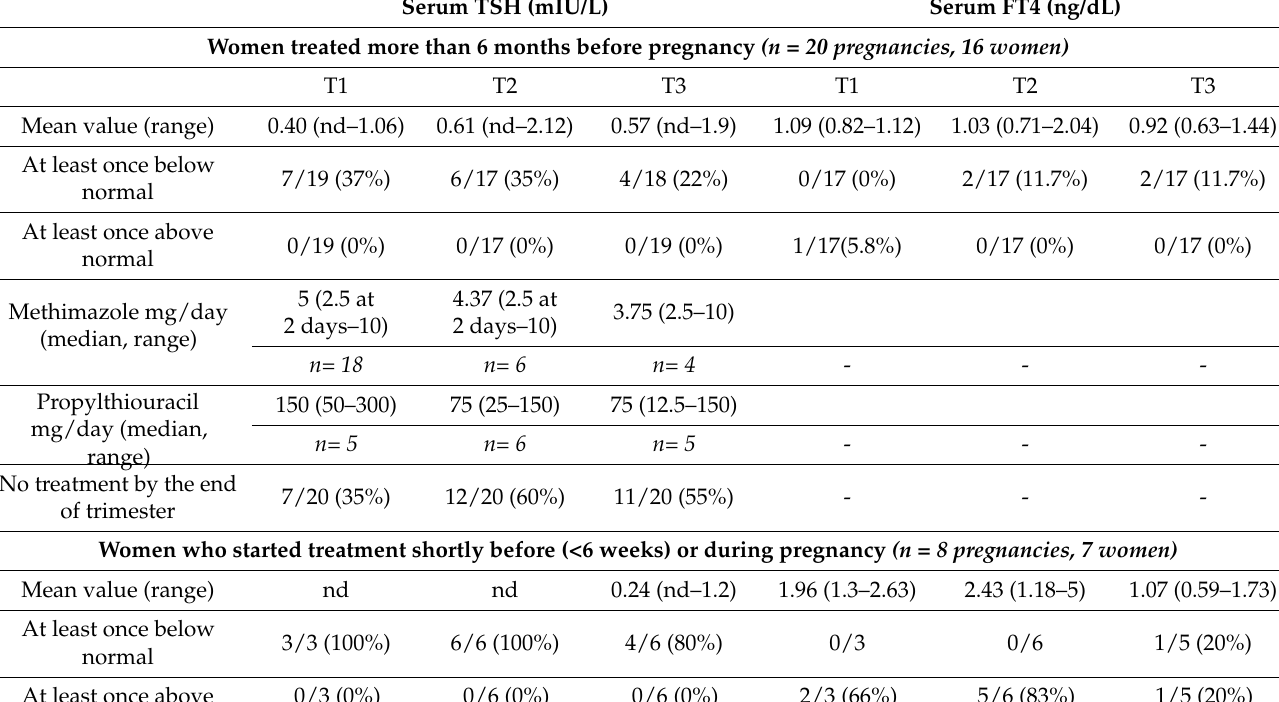
Table 3. Serum TSH, FT4, and the dosage of antithyroid drugs in women with hyperthyroidism treated during pregnancy. Serum TSH (mIU/L) Serum FT4